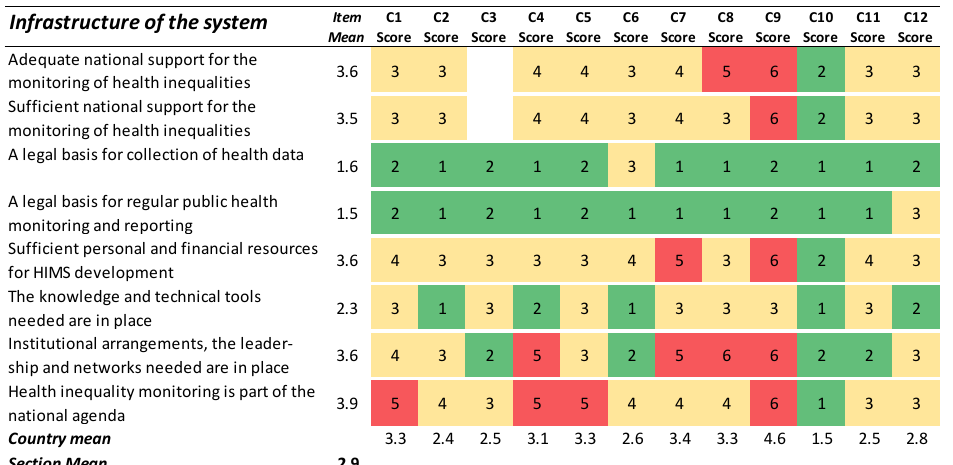
Figure 5. Results for the section ‘Evaluation’. Green cells (scores 1–2) indicate agreement with the statement. Yellow cells (scores 3–4) indicate partial agreement/disagreement, and red cells (scores 5–6) indicate the most challenging preconditions for an ideal HIMS.